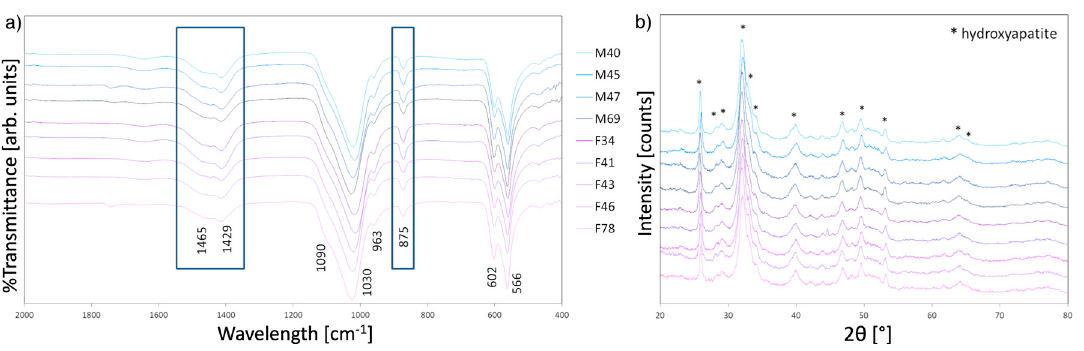
Figure 2. Composition of human bone samples: ( a ) FT-IR and ( b ) XRD spectra. Bands characteristic of CHA (1465, 1429, 875 cm − 1 ) [43,44] and HA (1090, 1030, 963, 602, 566 cm − 1 ) [45,46] are detected in FT-IR graphs, while all peaks detected in XRD patterns are characteristic of hydroxyapatite.